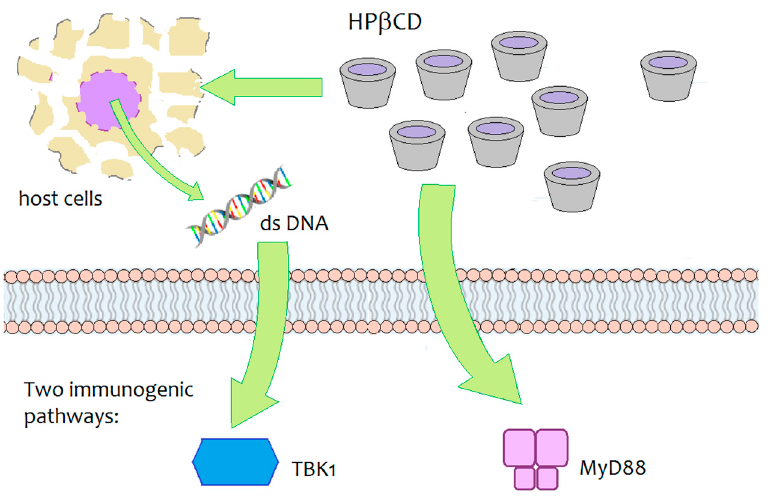
Figure 7. Schematic depiction of the biomolecular targets of HP β CD-mediated immunogenicity in mice